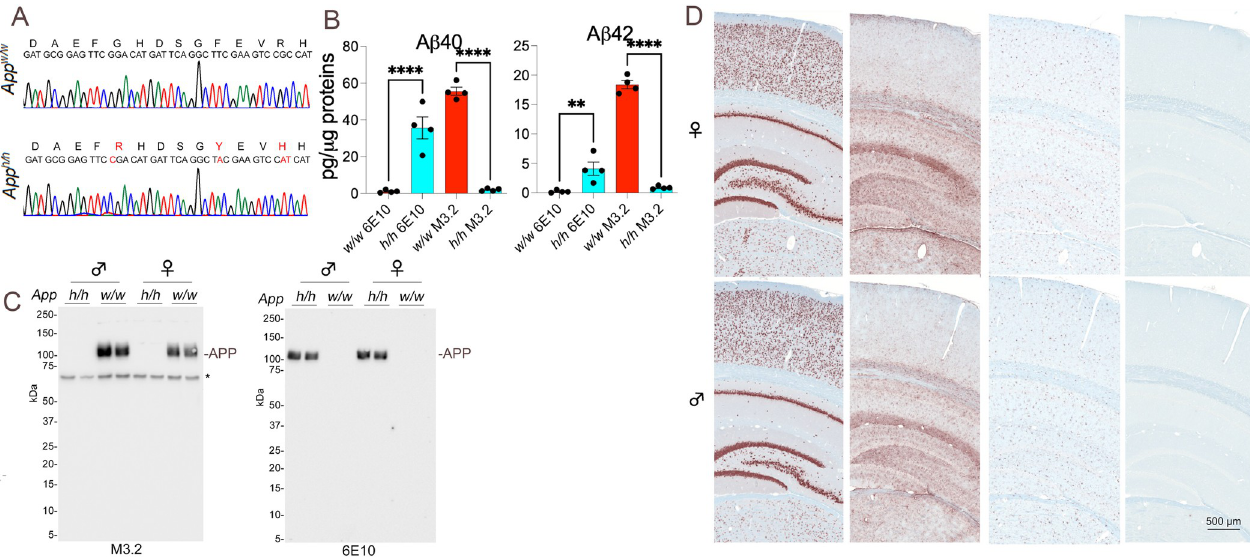
Fig 2. Characterization of App h/h rats. ( A ) To verify that the humanizing mutations were correctly inserted into App exon-16, exon-16 was amplified by PCR from App w/w and App h/h rats. PCR products’ sequencing showed correct insertion of the humanizing mutations into the App h/h genome. Nucleotides (G to C, T to A, and GC to AT) and amino acids (G to R, Y to F, and R to H) substitutions are in red. ( B ) The human A β -region specific antibody 6E10 detects A β 40 and A β 42 in App h/h but not App w/w rats’ brains. Conversely, the rat/mouse A β -region specific antibody M3.2 detects A β 40 and A β 42 in App w/w but not App h/h rats’ brains. ( C ) Western blot analysis of brain lysates shows that 6E10 detects APP in App h/h but not App w/w rats. Conversely, M3.2 detects APP in App w/w but not App h/h rats. ( D ) App h/h rats do not show AD-like histopathology at 14 months of age. Six male and six females rats were studied. The figure shows representative IHC in a representative male and female subject. The AT8 samples are not shown because no signal was detected.